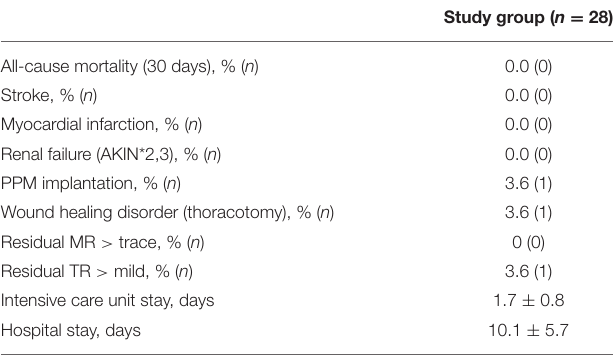
TABLE 2 | Periprocedural data. TABLE 3 | Clinical outcome and echocardiographic results at 30 days.